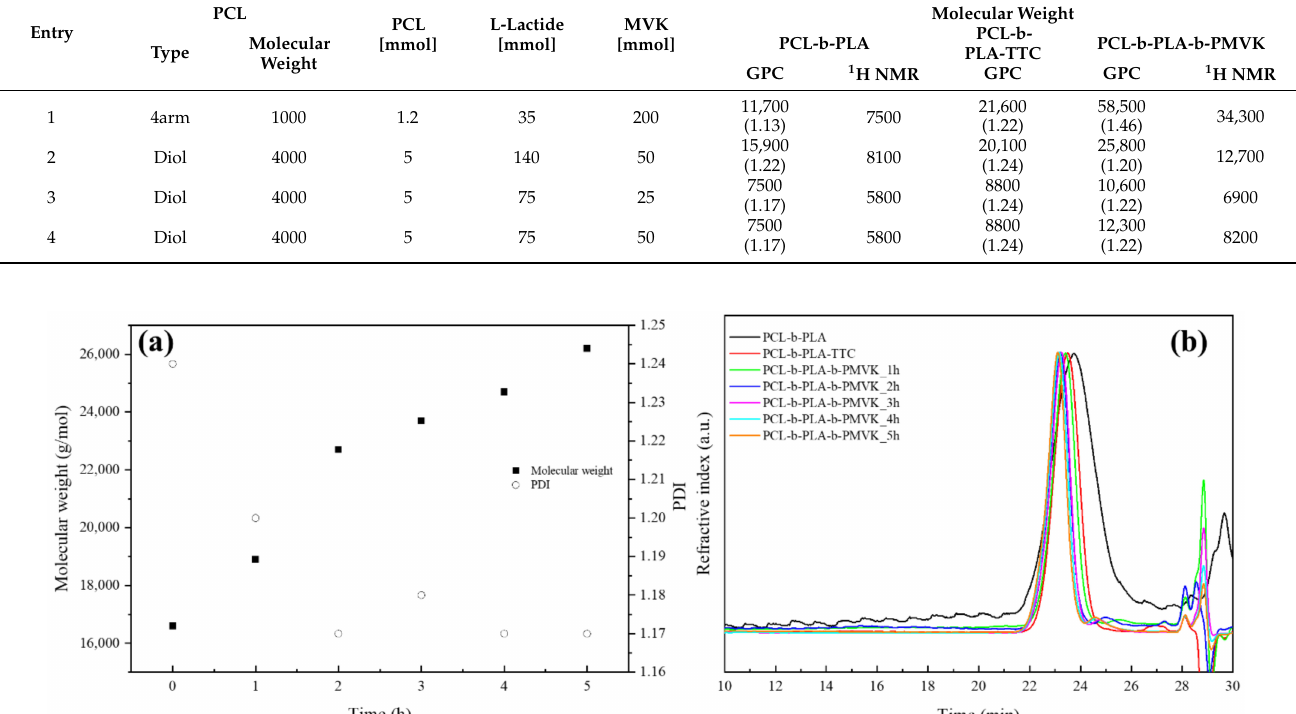
Table 1. Fabrication of porous microspheres based on PCL-b-PLA-b-PMVK.